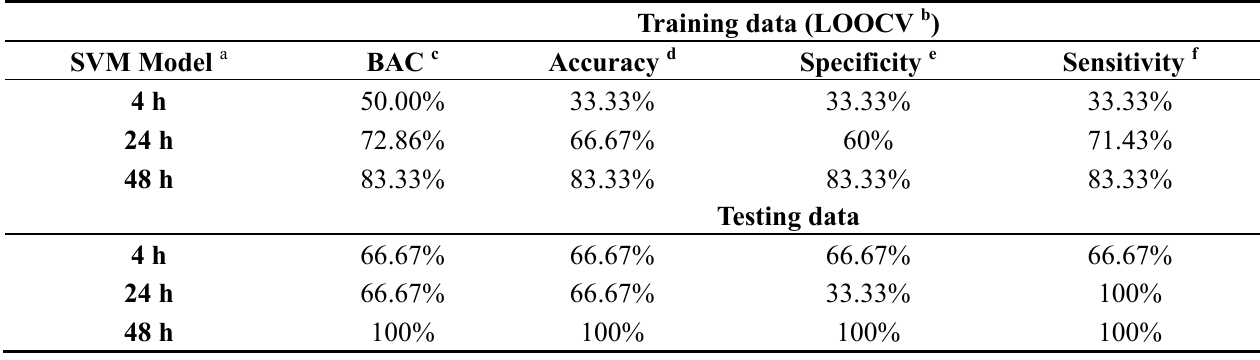
Table 1. The performance of predicting different time stages of hypoxia and normoxia in mixed